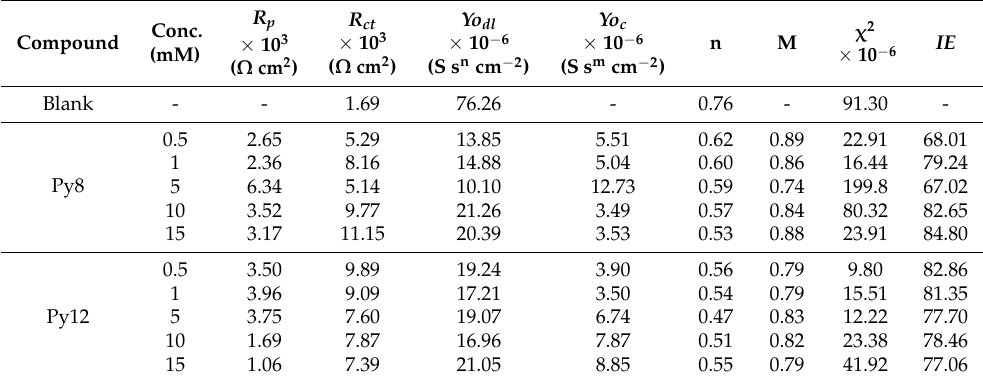
Figure 5. Electrochemical impedance spectra with equivalent circuit model fitting in the absence and presence of different concentrations of inhibitors ( a ) Py8 ( b ) Py12 in 3.5% NaCl solution (pH 1.5) using EN3B mild steel as working electrode. Table 4. EIS parameters for EN3B mild steel at varying concentrations of Py8 and Py12 in 3.5% NaCl solution (pH =